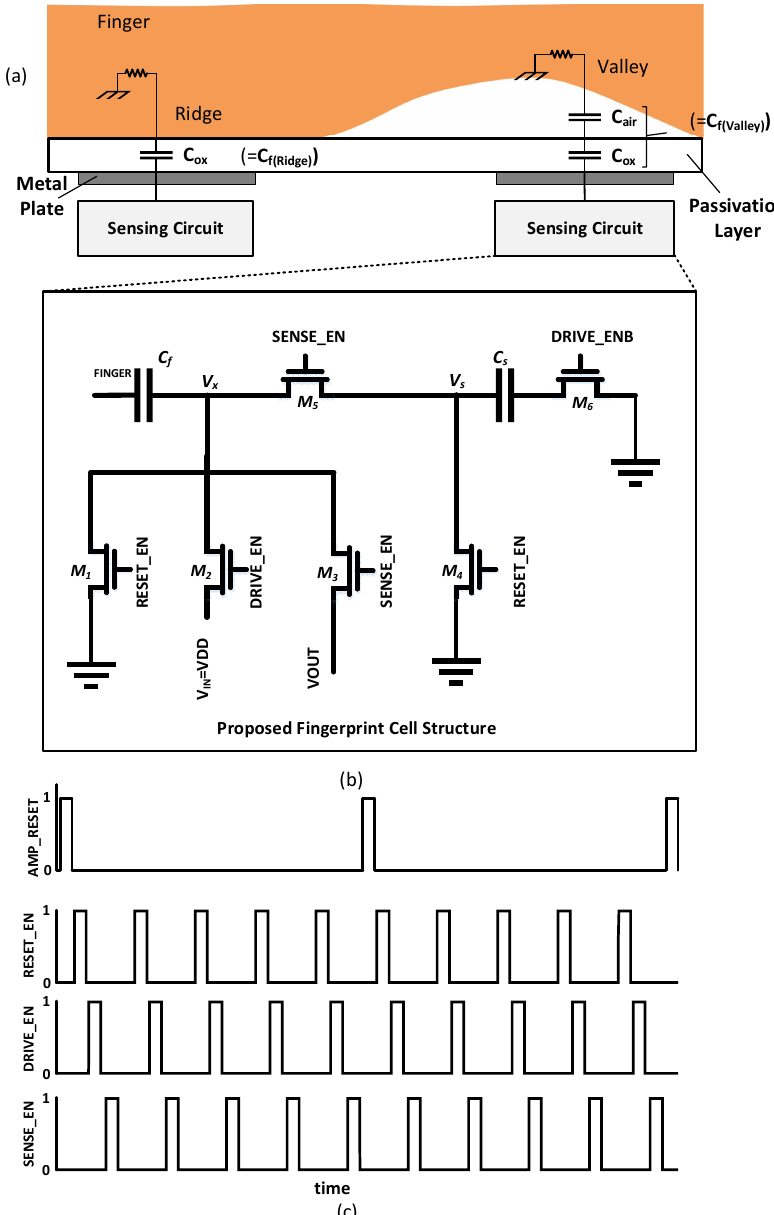
Figure 5. Capacitive fingerprint sensor structure: ( a ) The model of the capacitive fingerprint cell; ( b ) the proposed capacitive fingerprint sensor cell structure; ( c ) the control signal timing diagram.